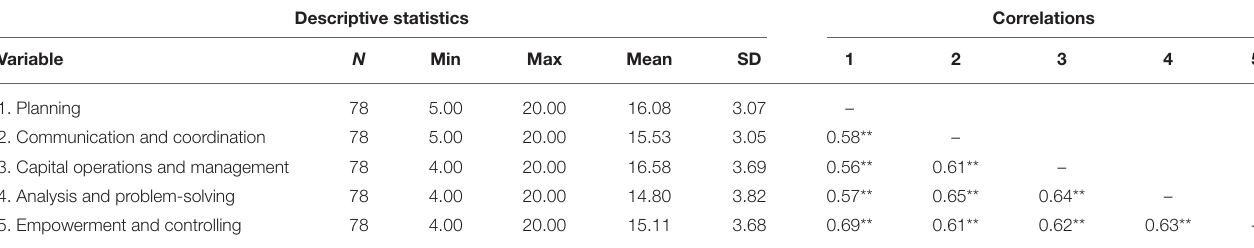
TABLE 1 | Minimums, maximums, means, standard deviations, and correlations for five dimensions. Descriptive